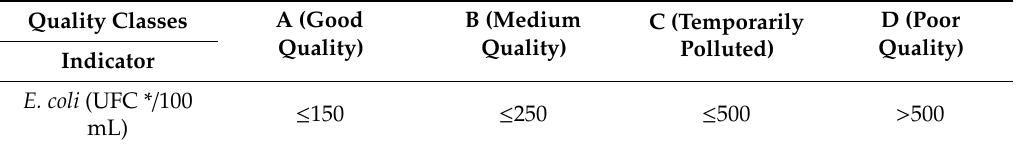
Table 2. Bathing water quality classes according to the Moroccan